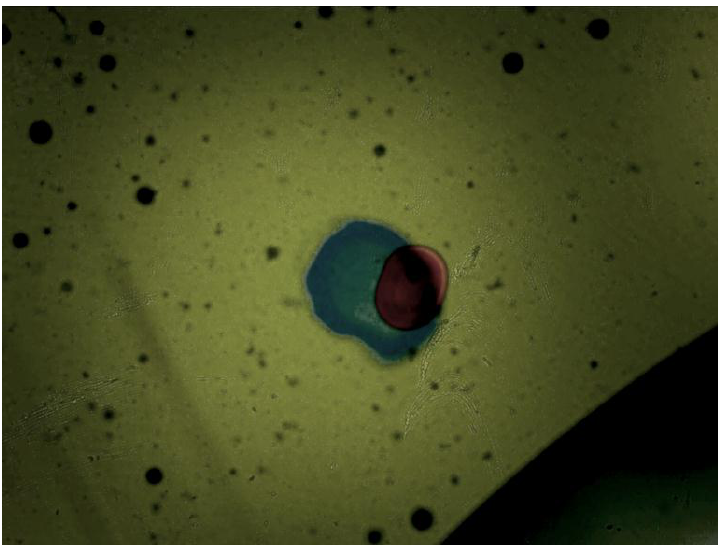
Figure 22. Sensor mounting the Gorilla ® glass disk. Sample is Texaco Meropa (medium absorptivity) and the flow speed is approximately 1.5 L/min. Asides, fibers and particles, non-homogeneity of the sample is evident, which may indicate the presence of other contaminants as varnishes.